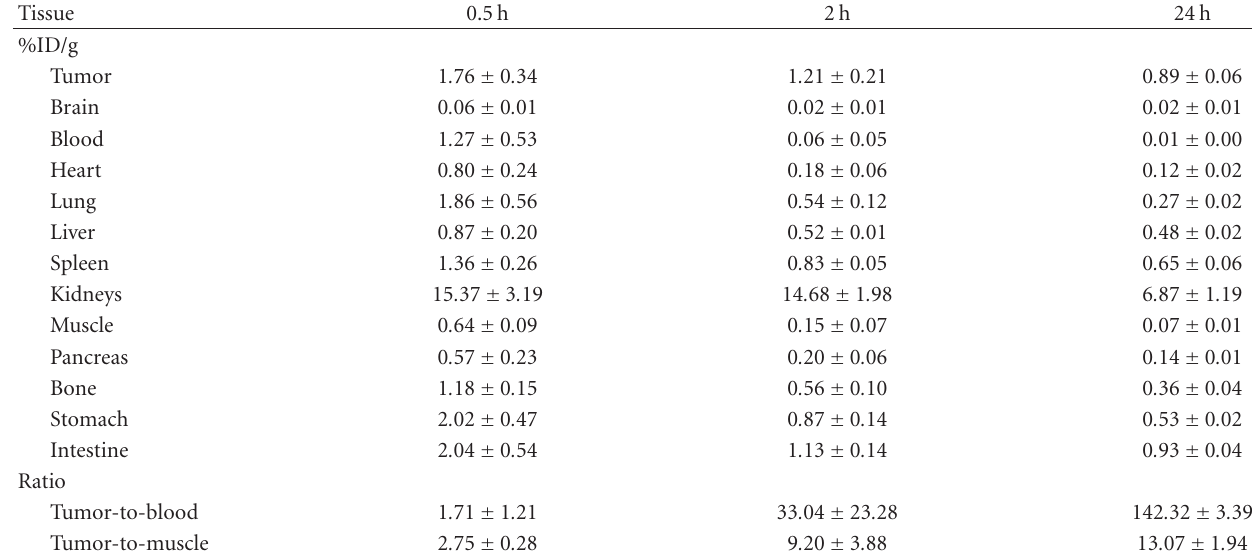
Table 3: Biodistribution results for 111 In-DOTA-AgRP-6E in nude mice bearing subcutaneous U87MG human glioblastoma xenografts. Data are expressed as the percent %ID/g after intravenous injection of the probe (0.296–0.444 MBq, 8–12 μ Ci) at 0.5, 2, and 24 h ( n =